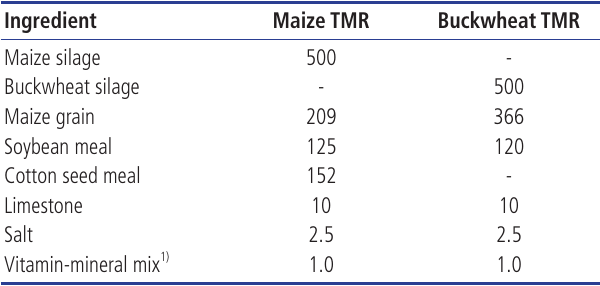
Table 1. Ingredient compositions of the experimental TMR (g/kg DM)